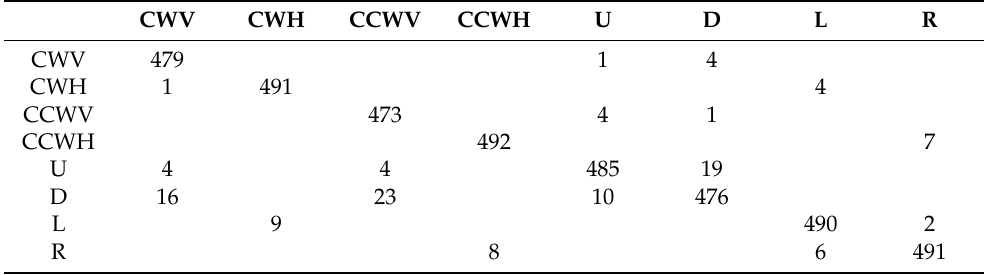
Table 9. Confusion matrix of axis-crossing code based recognition algorithm in the user- independent case.